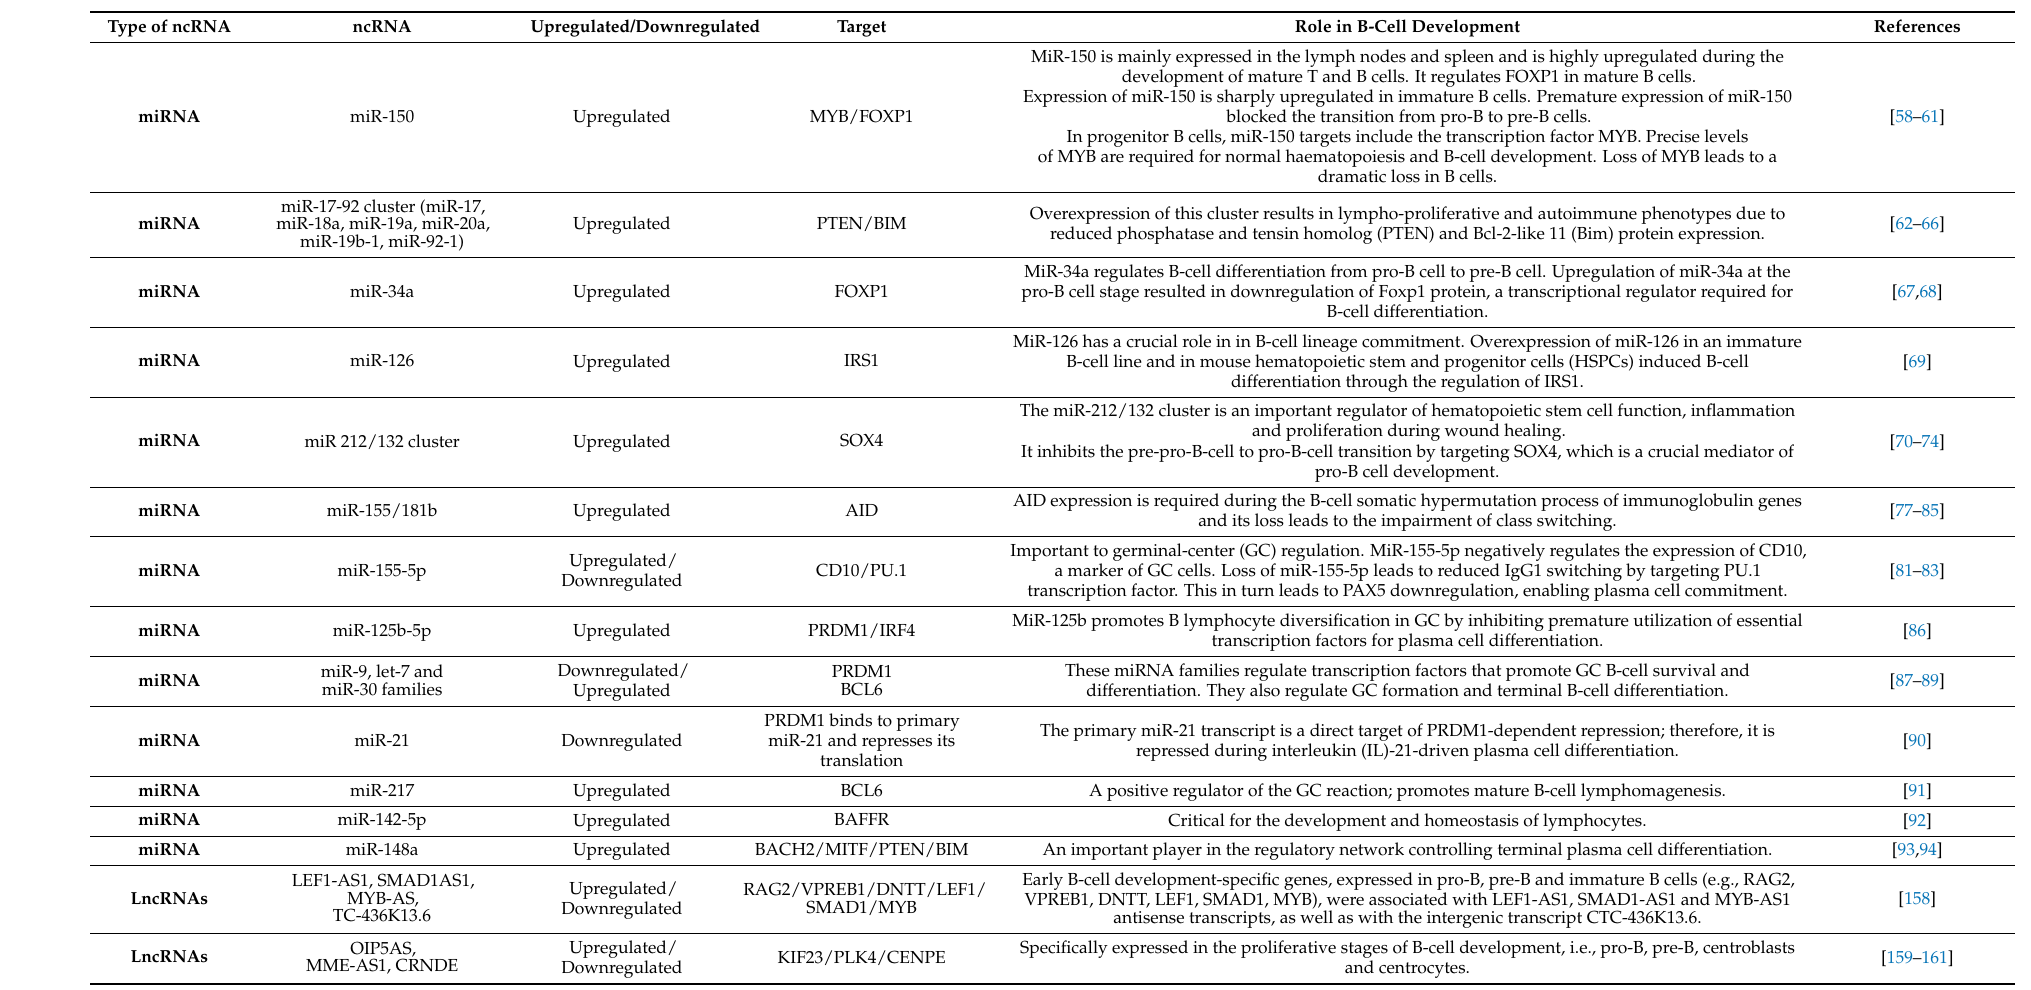
Table 1. ncRNAs in normal B-cell